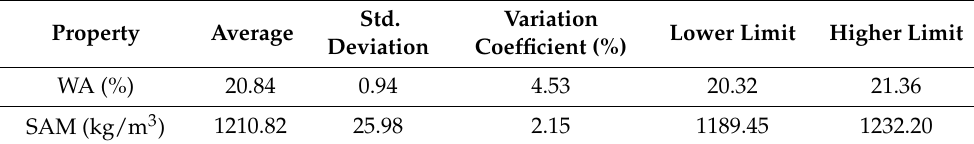
Table 2. Summary of the technological properties of the PBB.